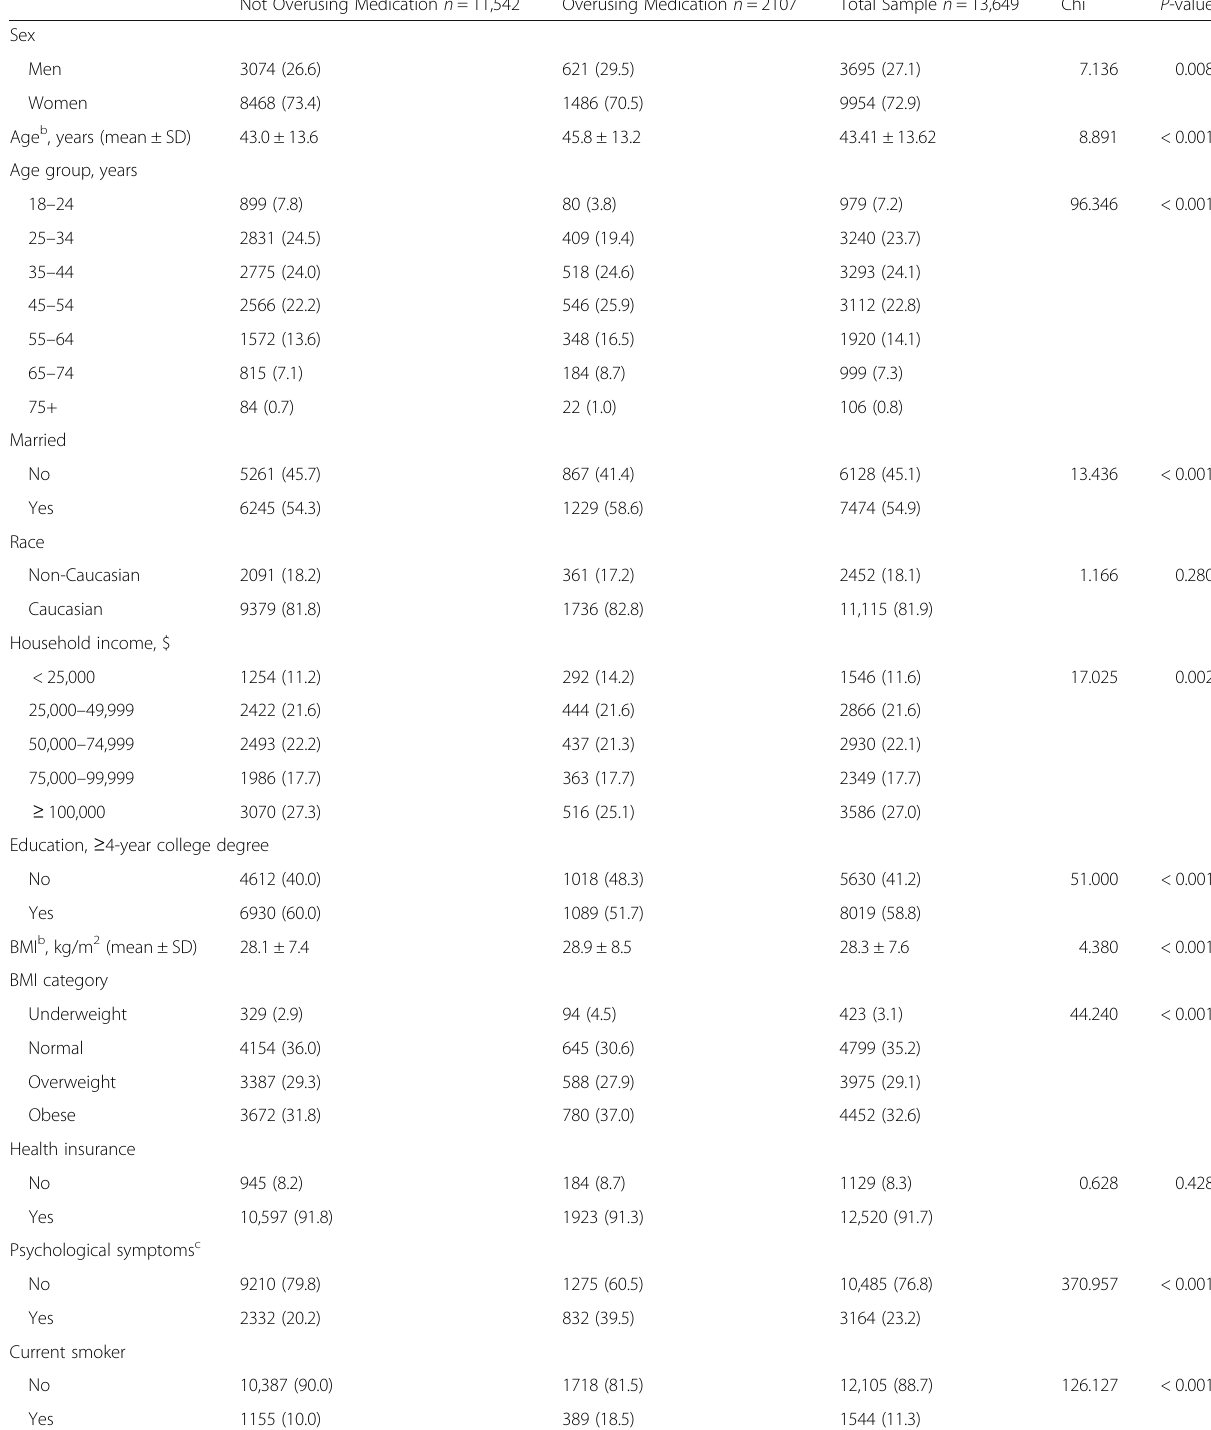
Table 1 Sociodemographics of Survey Respondents with Migraine According to Medication Overuse a Not Overusing Medication n =